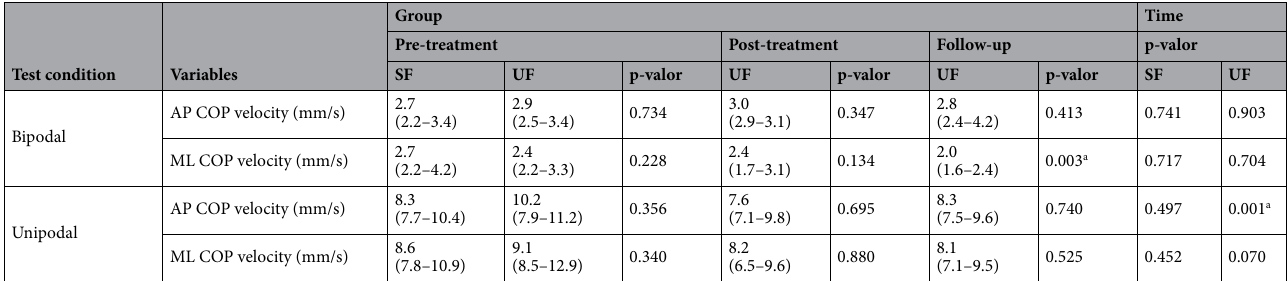
Table 2. Outcome measures at pre-treatment, post-treatment, and follow-up. Data are expressed as median (IQR). Time effect was analyzed with Friedman test. Between-group effect was analyzed using Mann– Whitney’s U tests at each time points. AP : Anteroposterior; COP : Centre of Pressure; ML : Mediolateral; SF : Stable footwear; UF : Unstable footwear. a Statistically significant difference (p < 0.05).